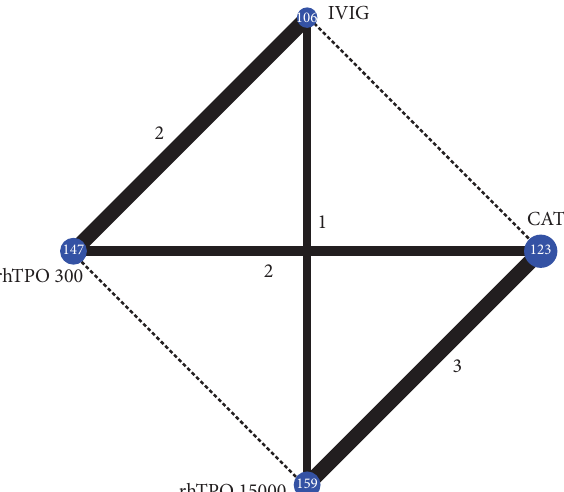
Figure 4: Evidence network of the length of ICU stay. NAT, no additional treatment; IVIG, intravenous immunoglobulin; rhTPO 300, 300U/kg/d recombinant human thrombopoietin; rhTPO 15000, 15000U/d recombinant human thrombopoietin.